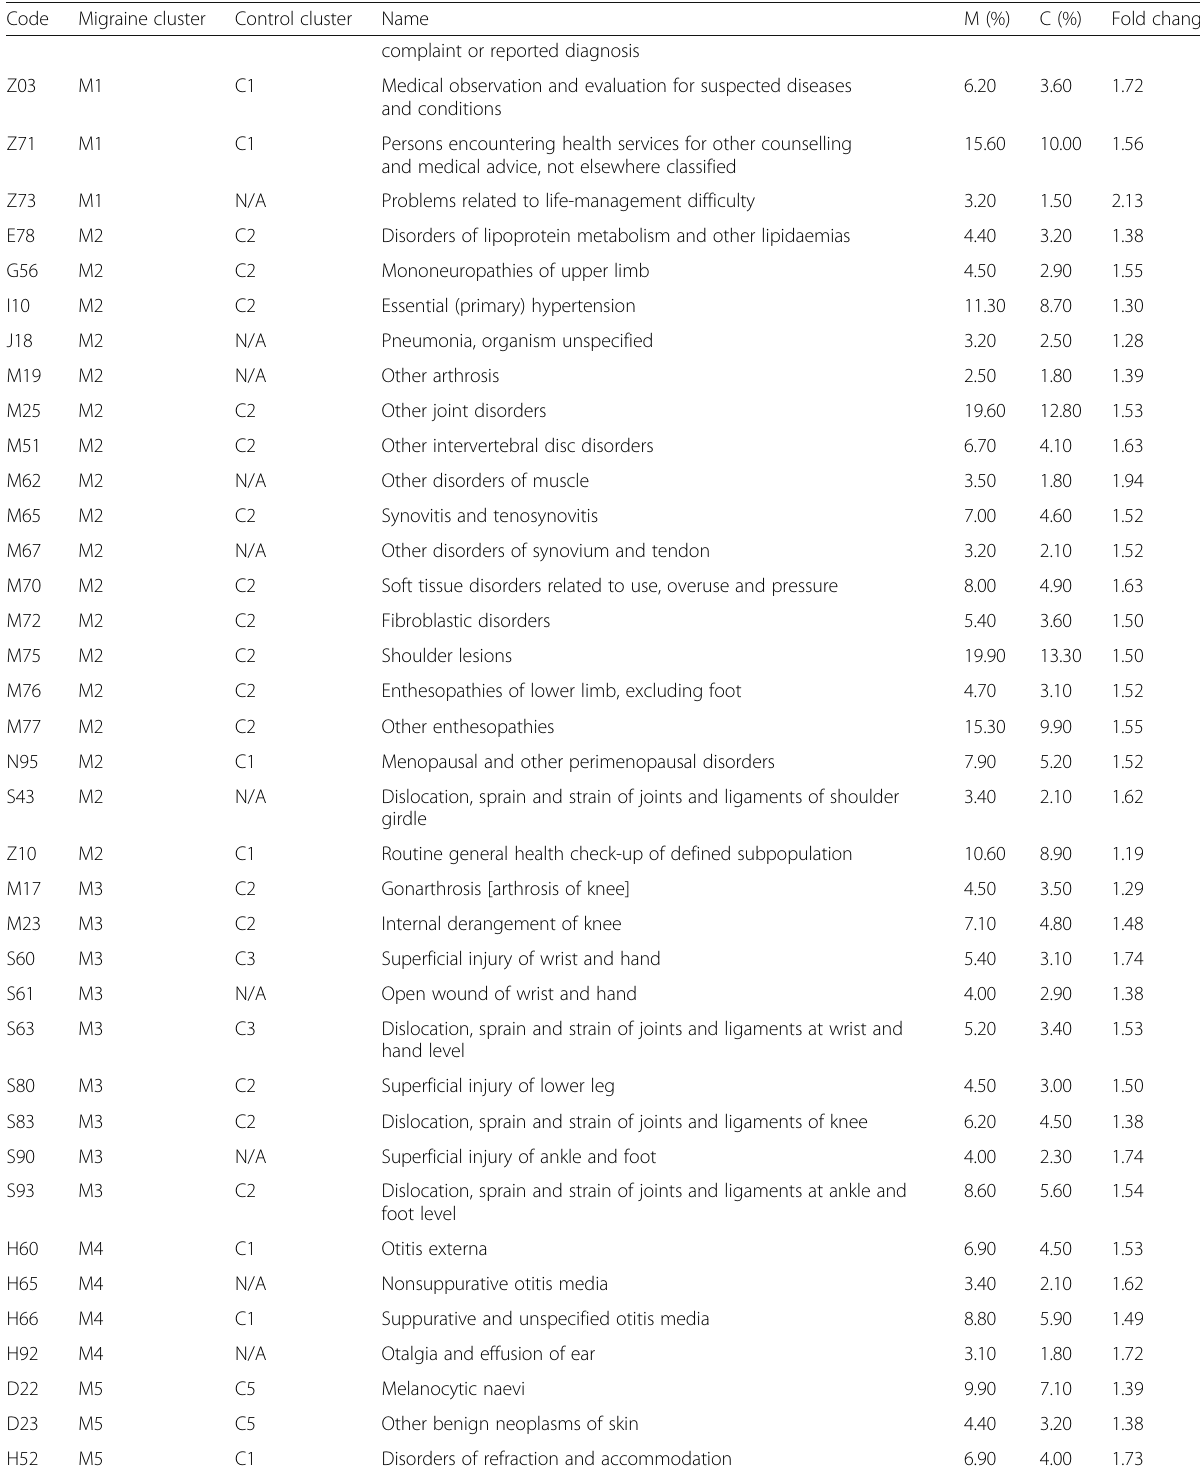
Table 2 List of diagnosis clusters from Fig. 2 sorted by their presence in migraine patients (2.5 – 20% prevalence) and compared to controls. Fold change column shows the prevalence in migraineurs divided by the prevalence in controls. All fold changes are greater than 1 indicating that migraine is associated with higher multimorbidity compared to controls. Due to high sample size, the difference in prevalence between migraineurs and controls is statistically significant ( p < 0.001) for each diagnosis